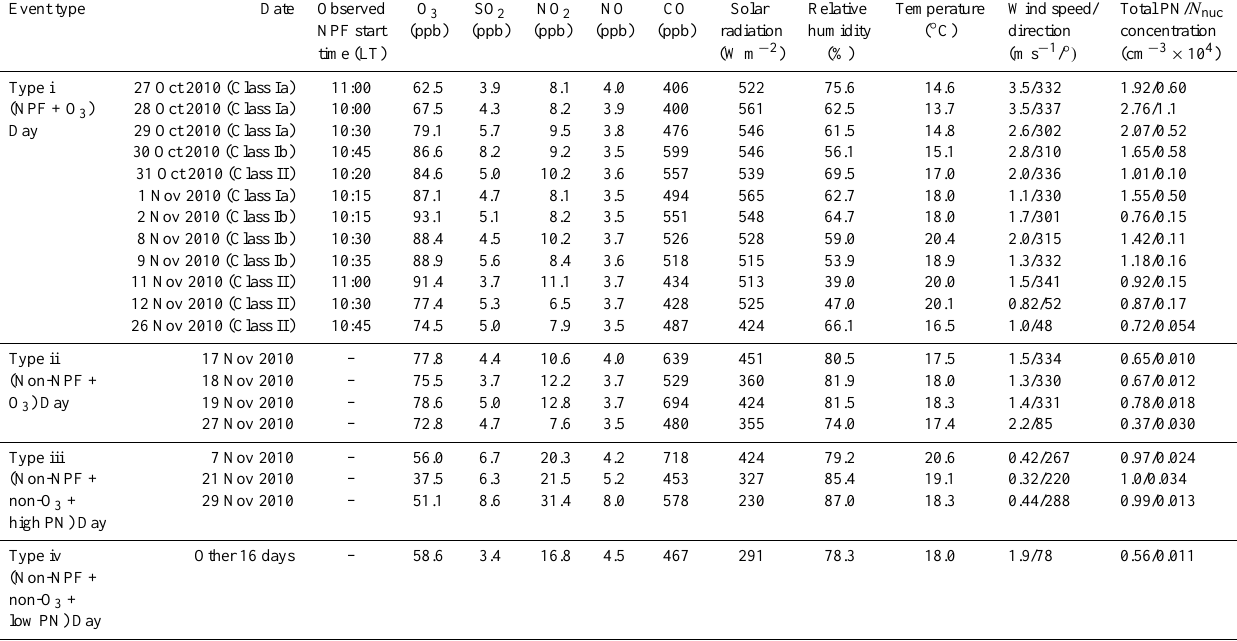
Table 1. Summary of the observed formation start time, the hourly average mixing ratios of trace gases (SO 2 , NO x , CO and O 3 ) , meteoro- logical conditions (UV, T , RH and wind), total PN concentration (5.5–350nm) and nucleation mode particle concentration ( N nuc ) in four different types of events classified from NPF event days (class Ia, Ib and II events) and non-NPF event days from 08:00 to 16:00LT observed at